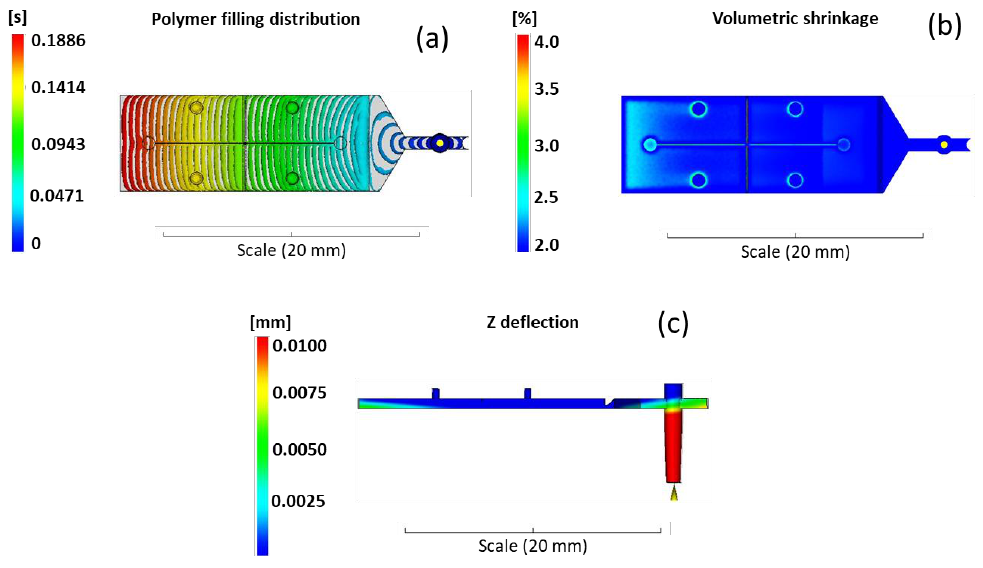
Figure 3. ( a ) Polymer filling distribution (time contour plot), ( b ) volumetric shrinkage (range 2% – 4%), and ( c ) component deflection in the Z direction (out of XY plane). Table 1. Values for the microinjection moulding process parameters obtained from the simulations for Acryrex ® CM-211 PMMA (polymethylmethacrylate).